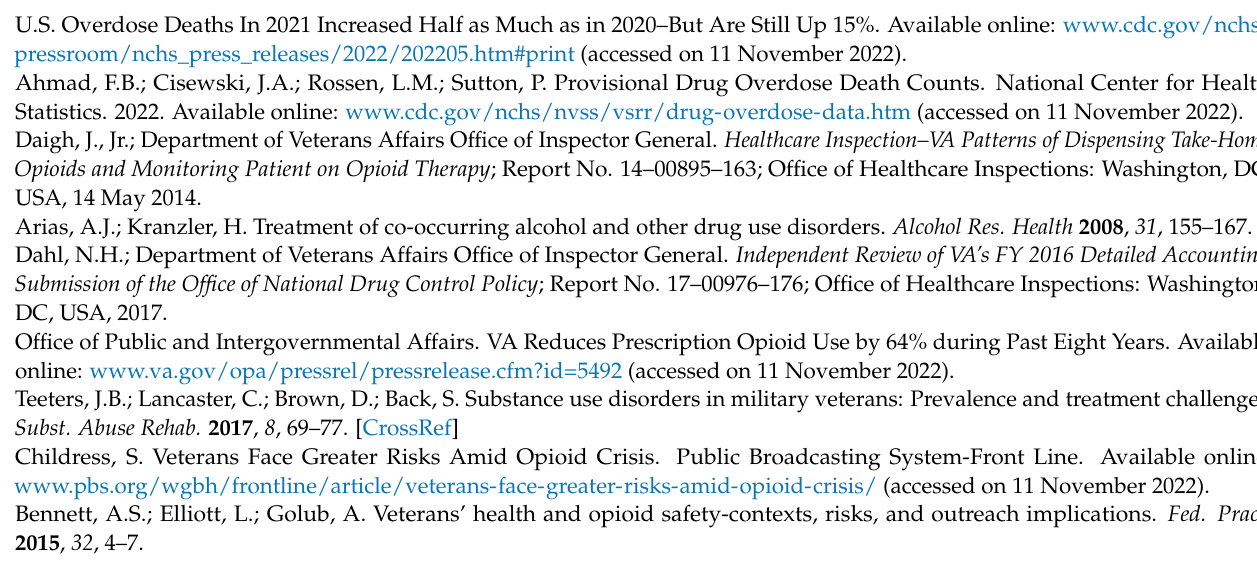
samples: 400 to 1800 cm − 1 . Figure S2. Spectra of samples for buprenorphine concentration calibration curve Figure S3. Signal-to-noise software was used to determine peak height with a baseline from 620 to 660 cm − 1 for Samples 1–20. Peak heights indicated in parentheses. Figure S4. Nine repeat analyses for a 50 ng/mL prepared sample that included SLE preparation and SERS